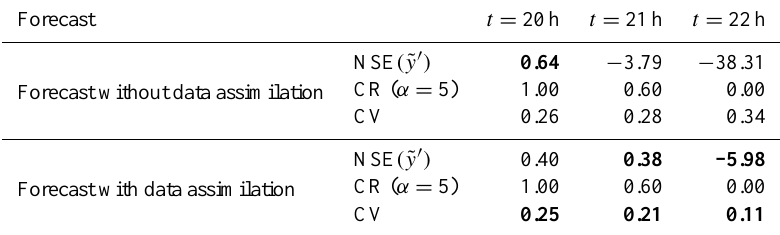
Table 6. Results of the validation measures for the April 2004 flood event.